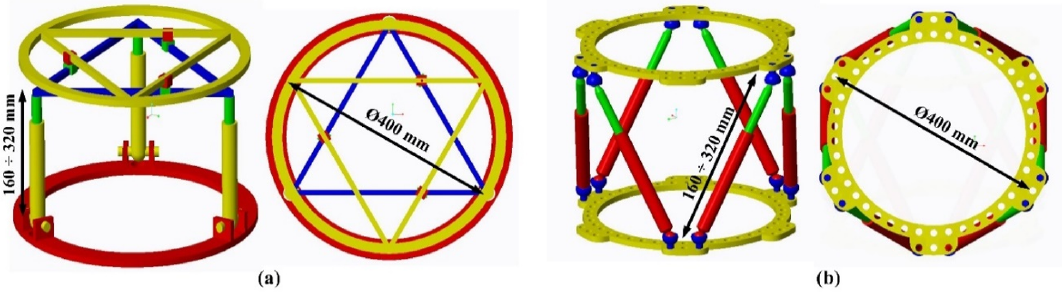
Figure 8. General dimensions of the proposed hybrid mechanism (a) and the Stewart manipulator (b) .